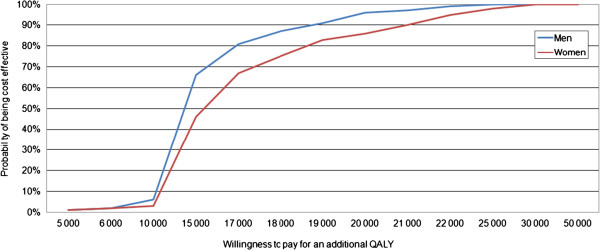
Cost-effectiveness acceptability curves for men and women. Each curve indicates, for a specific willingness-to-pay for an additional QLAY (horisontal axis), the likelihood (vertical axis) that GH treatment is cost-effective, compared to no treatment.